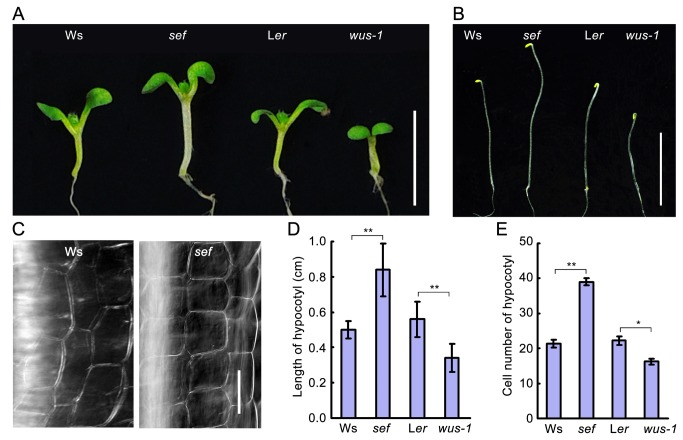
Hypocotyl phenotypes of sef and wus-1.(A) Hypocotyl phenotype of WUS gain-of-function (sef) and loss-of-function (wus-1) mutant seedlings grown in 16-h light/8-h dark. Bar = 1 cm. (B) Hypocotyl length of dark-grown seedlings of sef and wus-1 mutant and their corresponding wild type. Bar = 1 cm. (C) Comparison of the cell number in a same length of hypocotyl in 8-day-old seedlings. Bar = 50 µm. (D) Hypocotyl length of 8-day-old seedlings. Data are means ± SD (n > 15) Student’s t test, **P < 0.01. (E) Hypocotyl cell number of 8-day-old seedlings. Data are means ± SD (n > 15). Student’s t test, **P < 0.01, *P < 0.05.